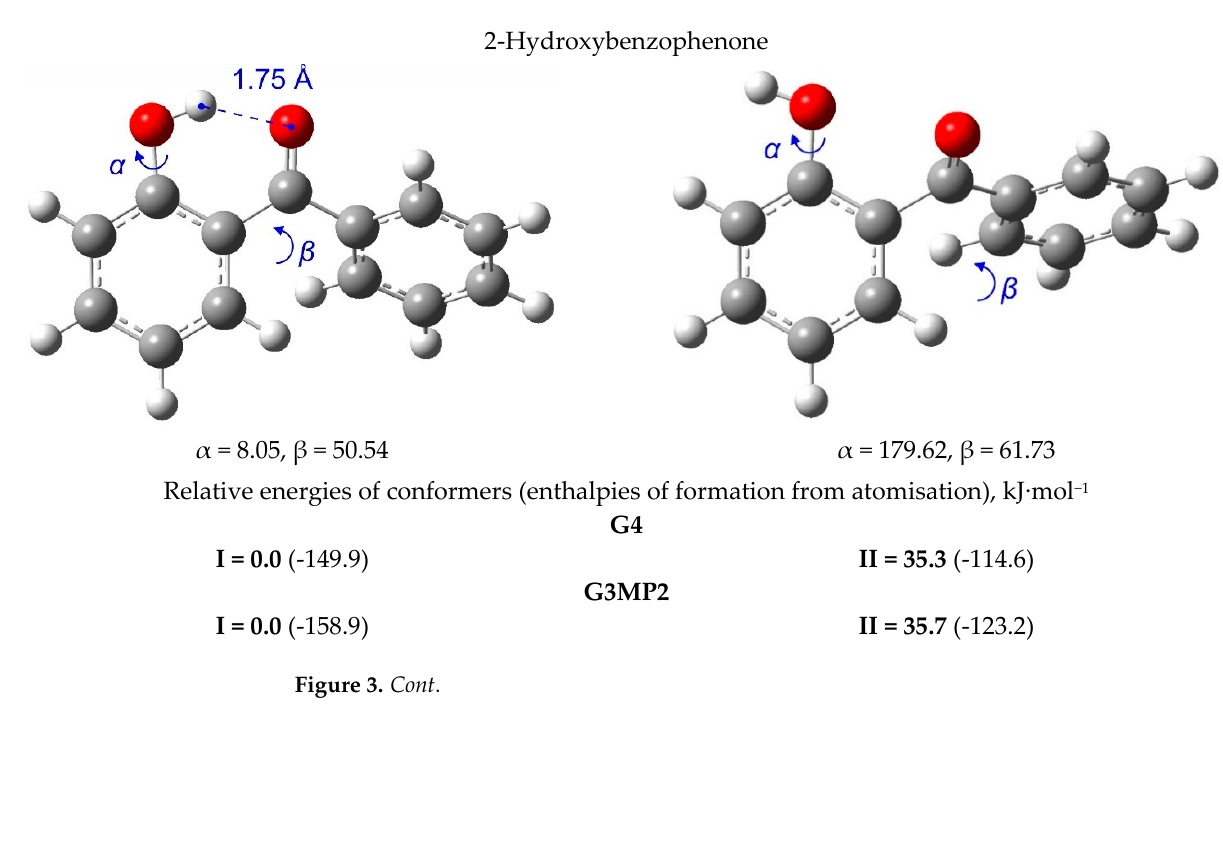
a Uncertainties in this table are twice standard deviations. Values in brackets appear to be incorrect. b Taken from Table 4. c Calculated by the G4 method using reactions 9–14 and using experimental ∆ f H o m (g)-values for the reaction participants. The expanded uncertainty assessed to be ± 3.5 kJ · mol − 1 [11]. d Calculated by the G4 method using atomisation reactions. The expanded uncertainty assessed to be ± 3.5 kJ · mol − 1 [11]. e Weighted mean value. The uncertainties were taken as the weighing factor. f Calculated by the G4 method using reaction: benzophenone + butane = acetone+ 2 × toluene and using experimental ∆ f H o m (g)-values for the reaction participants [42]. g Results evaluated and recommended in our recent work [36].